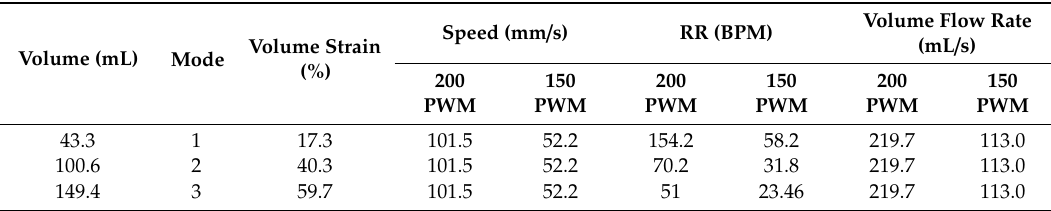
Table 2. The specifications of the di ff erent operating modes of the respiratory simulator. PWM: Pulse Width